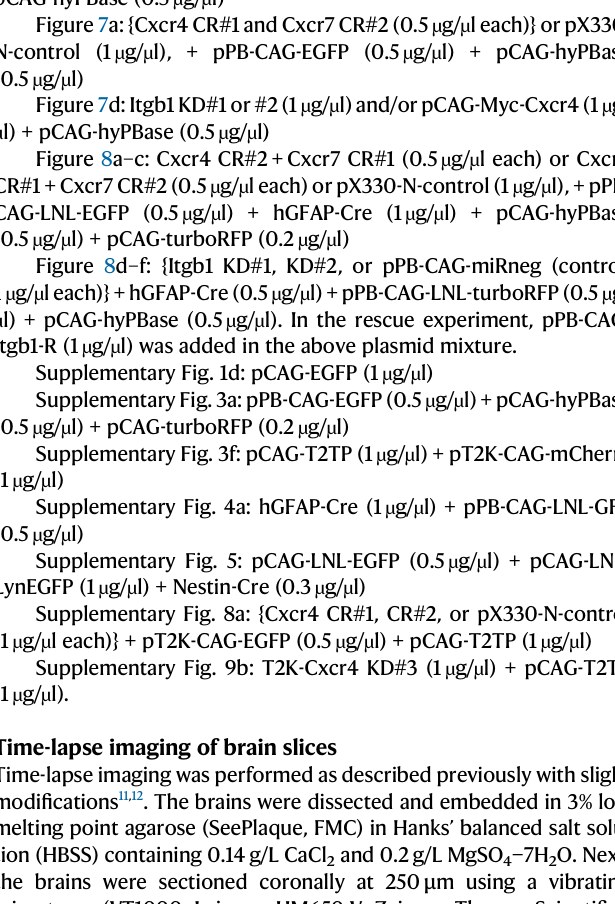
(0.5 µ g/ µ l) + pCAG-turboRFP (0.2 µ g/ µ l) Supplementary Fig. 3f: pCAG-T2TP (1 µ g/ µ l) + pT2K-CAG-mCherry (1 µ g/ µ l) Supplementary Fig. 4a: hGFAP-Cre (1 µ g/ µ l) + pPB-CAG-LNL-GFP (0.5 µ g/ µ l) Supplementary Fig. 5: pCAG-LNL-EGFP (0.5 µ g/ µ l) + pCAG-LNL- LynEGFP (1 µ g/ µ l) + Nestin-Cre (0.3 µ g/ µ l) Supplementary Fig. 8a: {Cxcr4 CR#1, CR#2, or pX330-N-control (1 µ g/ µ l each)} + pT2K-CAG-EGFP (0.5 µ g/ µ l) + pCAG-T2TP (1 µ g/ µ l) Supplementary Fig. 9b: T2K-Cxcr4 KD#3 (1 µ g/ µ l) + pCAG-T2TP (1 µ g/ µ